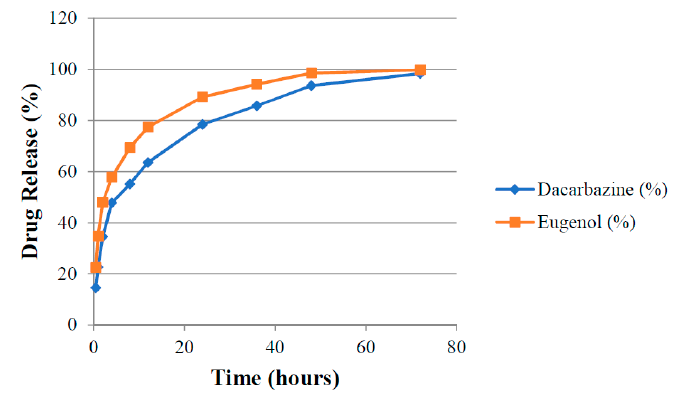
Figure 10. Cumulative release of Dacarbazine and Eugenol from uncoated liposomes.